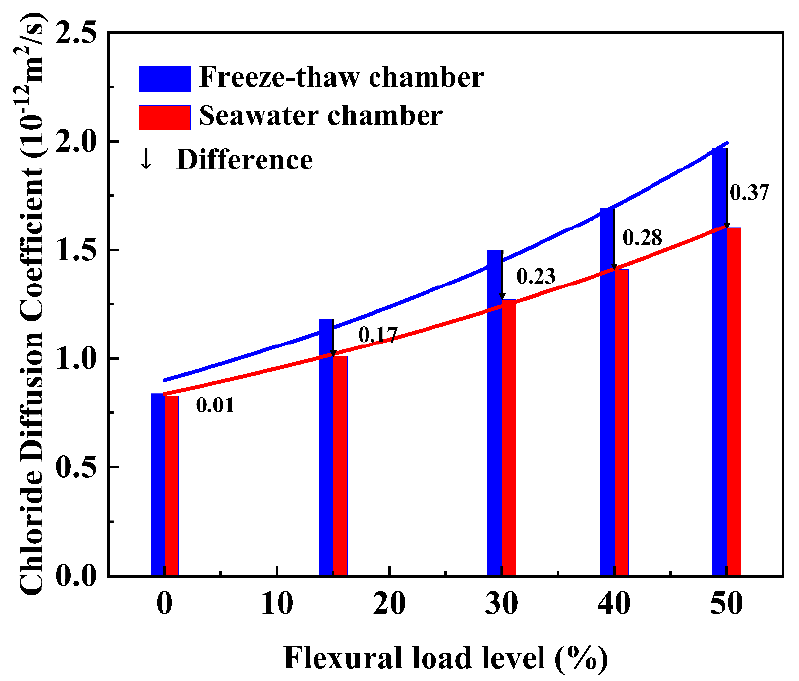
Figure 4. The results of the chloride diffusion coefficient from the seawater chamber and freezing and thawing chamber.